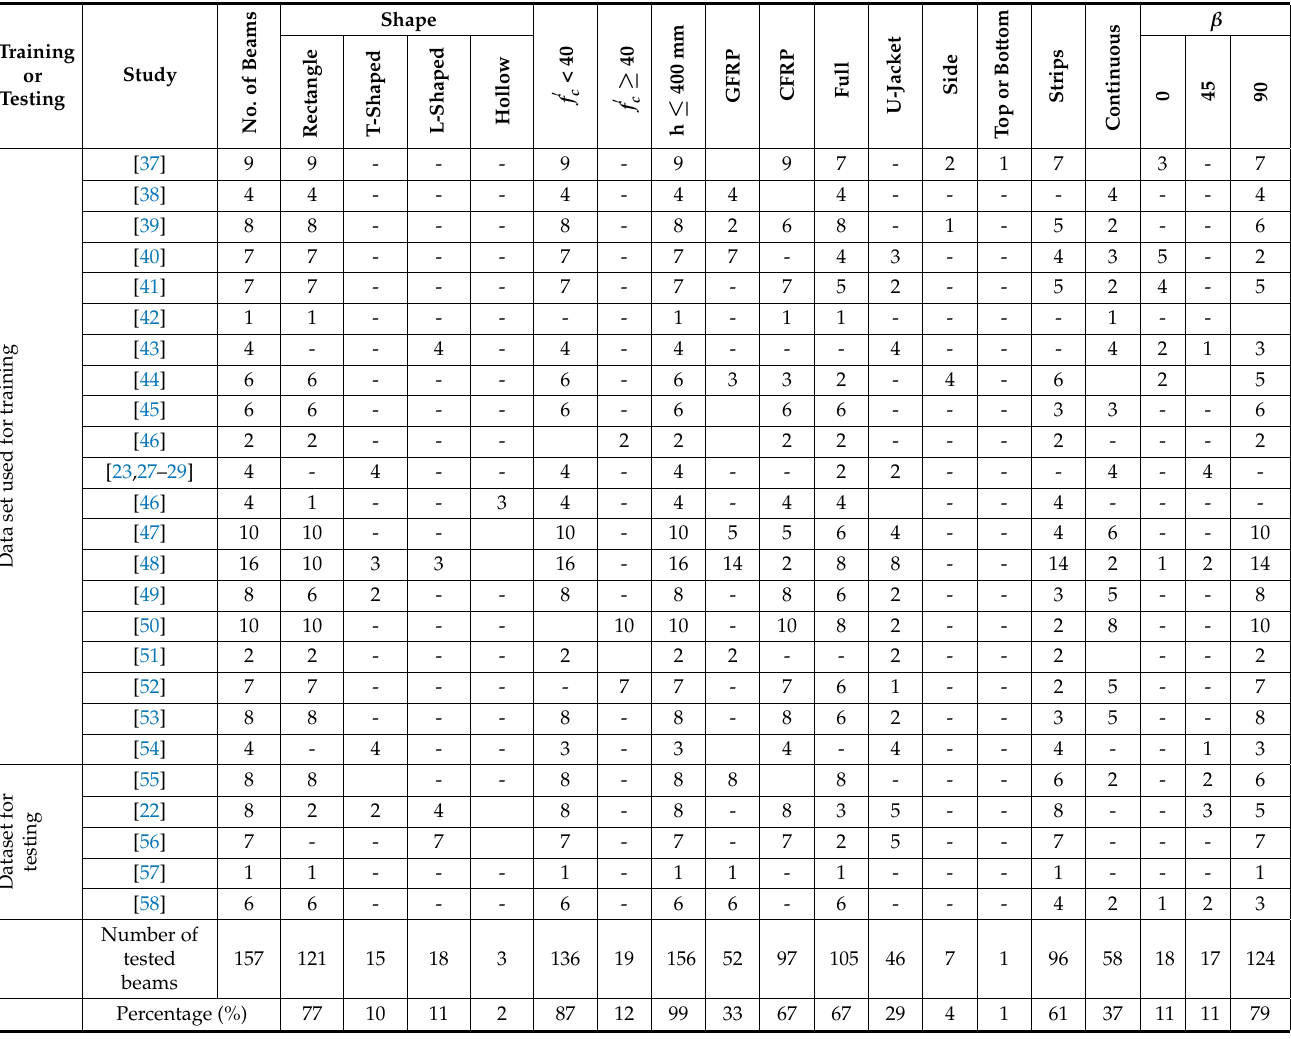
Table 2. Profile of previous experimental